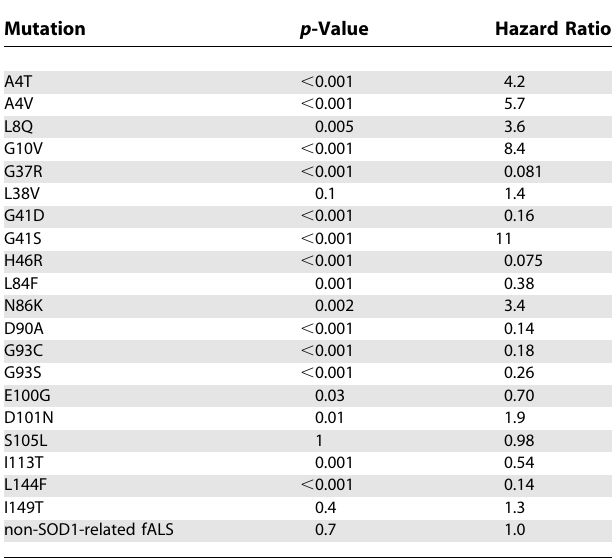
Table 1. SOD1 Mutations Encode Inherently Different Prognoses